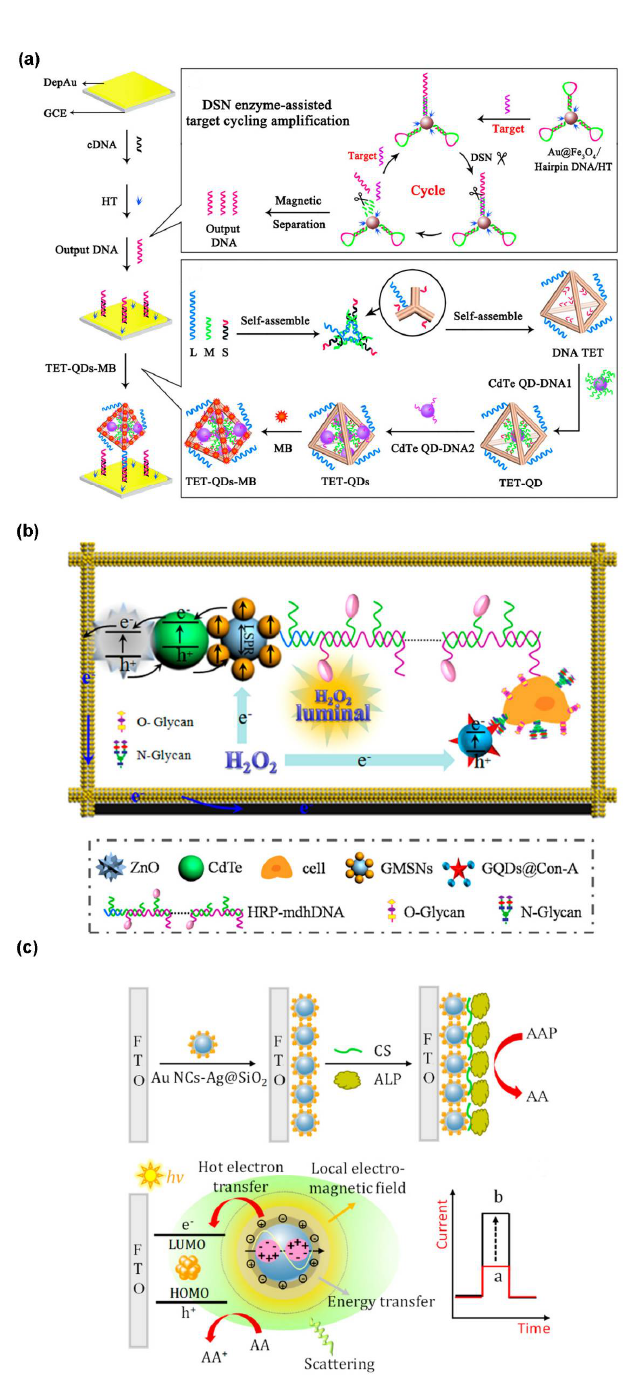
Figure 2. ( a ) Schematic diagrams of the PEC biosensor for miRNA-141 determination. Reprinted with permission from ref. [18]. Copyright 2018, American Chemical Society; ( b ) schematic representation of the PEC analytical principle for N-glycan expression. Reprinted with permission from ref. [44]. Copyright 2017, American Chemical Society; ( c ) the energy diagram of the SPR effect-induced photocurrent enhancement system. Reprinted with permission from ref. [50]. Copyright 2020, American Chemical